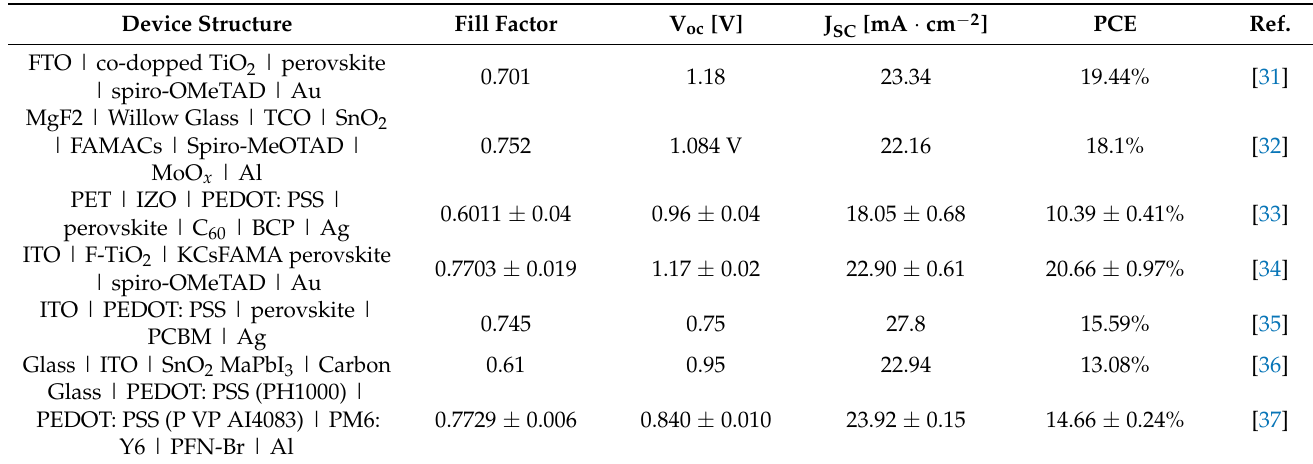
Table 4. Typical examples of flexible solar